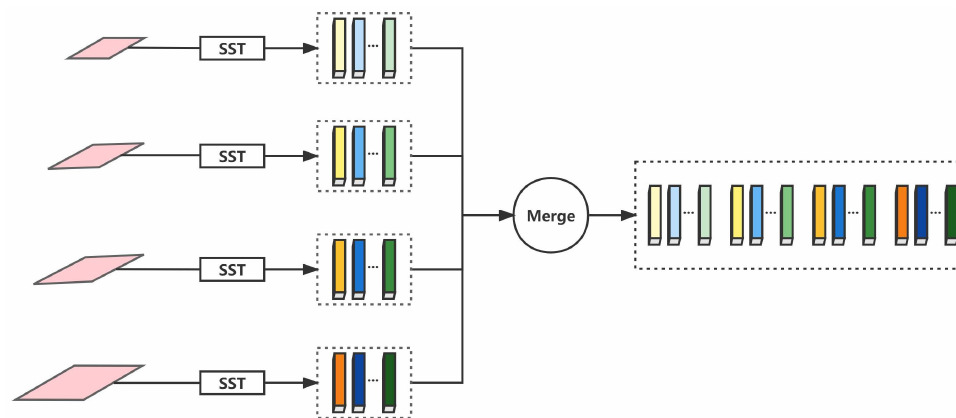
Figure 4. The diagram of the multi-tokens.